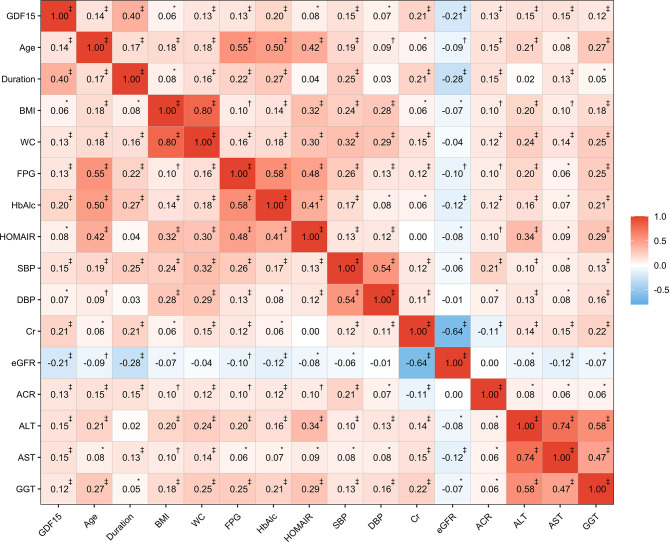
Correlations between GDF-15 and clinical characteristics. The values in the cell represent the correlation coefficients based on spearman correlation. *P < 0.05; †P < 0.001; ‡P < 0.0001.